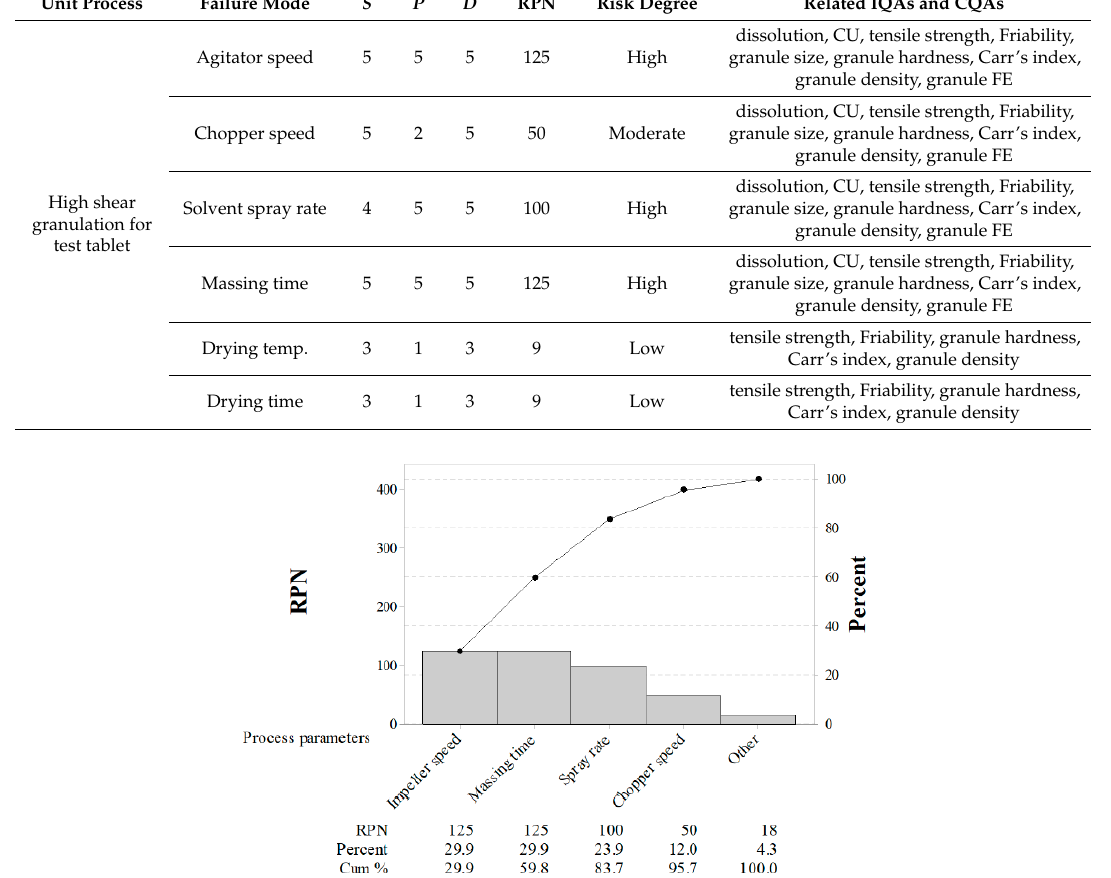
Figure 1. Pareto chart of the risk priority number (RPN). Individual values are represented in descending order by bars, and the cumulative total is represented by the line. The left vertical axis is the RPN. The right vertical axis is the cumulative percentage of the RPN.